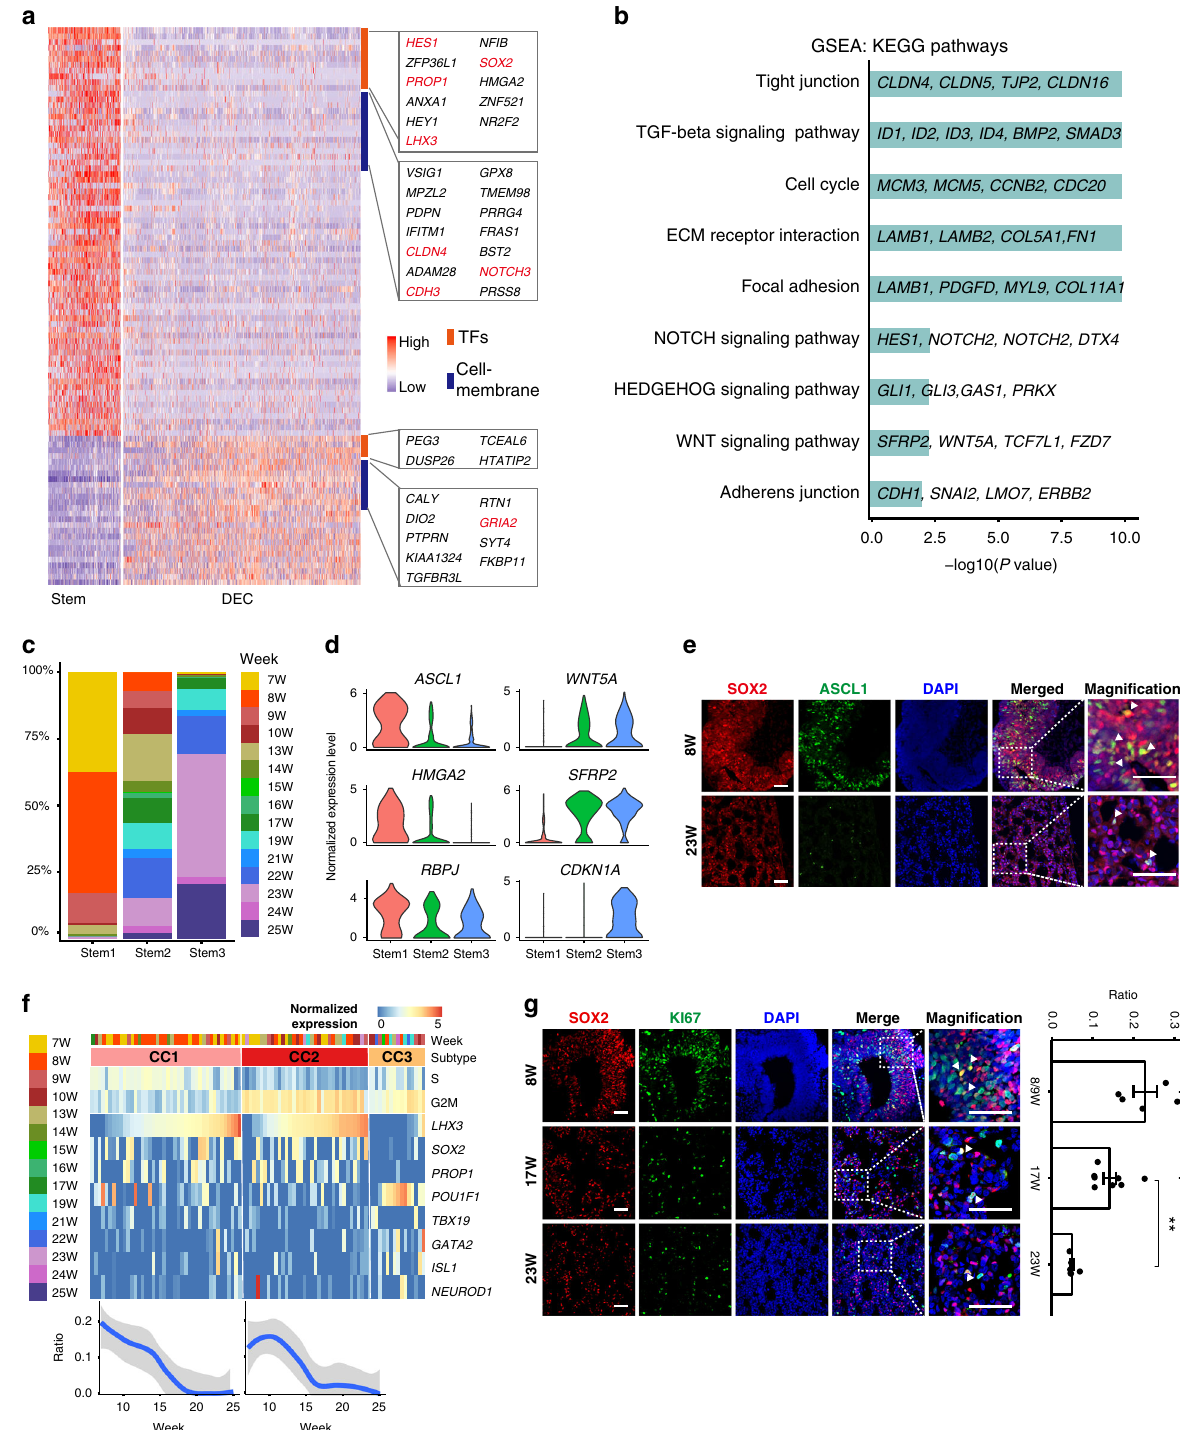
positive stem cells, and a small portion were POU1F1 or TBX19 - positive cells, which were ver fi ed by immuno fl uorescence staining (Fig. 2f and Supplementary Fig. 3f). The proportion of cycling stem cells in the total stem cell population gradually decreased from the early to late stages (20% in the early stages, 10% in the middle stages, and less than 5% in the late stages; Fig. 2f), which was validated by coimmunostaining for SOX2 and Ki67 in the pituitaries of 8-, 17- and 23-week fetuses (Fig. 2g). These